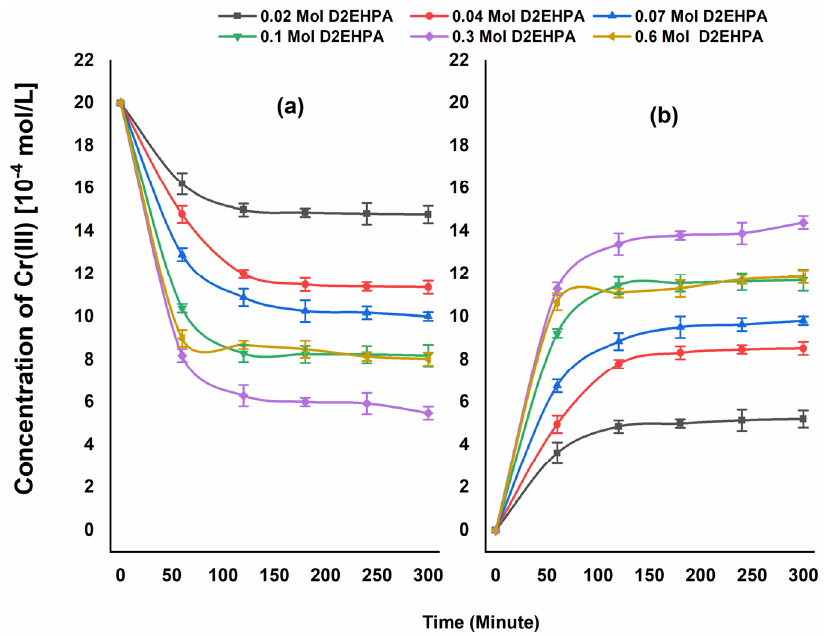
Figure 1. Cr (III) concentration at different D2EHPA concentrations in the feed phase ( a ) and stripping phase ( b ); [CrIII] = 20 × 10 − 4 mol/L, [HCl] = 1.25 mol/L.